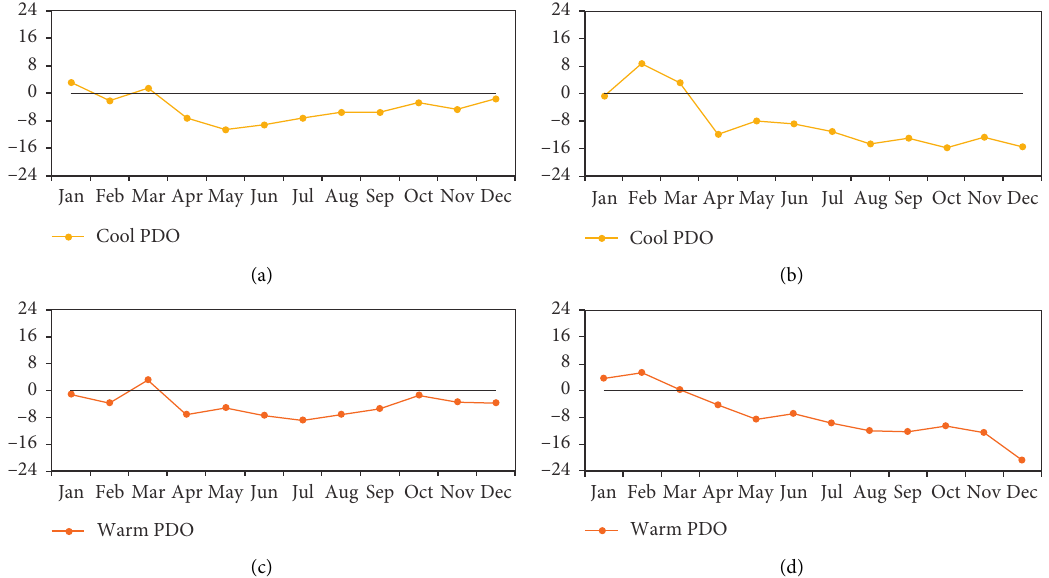
Figure 11: Monthly averaged OLR anomalies over the western equatorial Pacific (10 ° S–40 ° N, 110 ° –140 ° E) in cool ((a) and (b)) and warm ((c) and (d)) PDO phase from developing to decaying CP El Niño years. (a) Developing period, western Pacific OLR. (b) Decaying period, western Pacific OLR. (c) Developing period, western Pacific OLR. (d) Decaying period, western Pacific